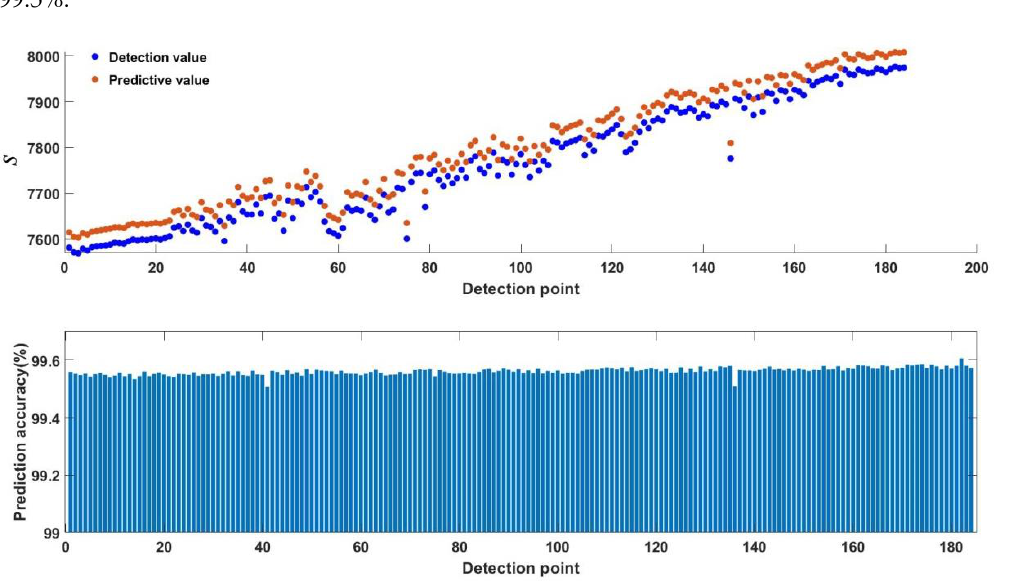
Figure 9. The accuracy of the fitting function.